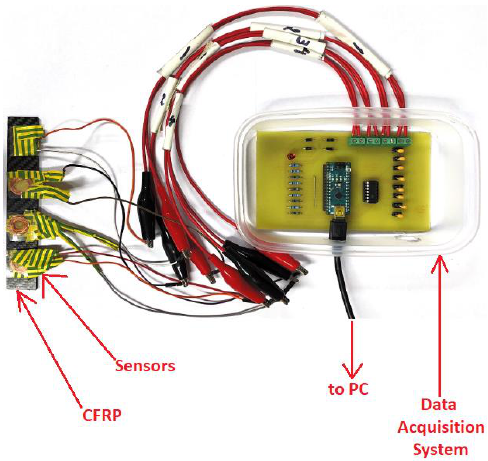
Figure 9. CFRP with four sensors on the top surface connected to the fabricated data acquisition system.